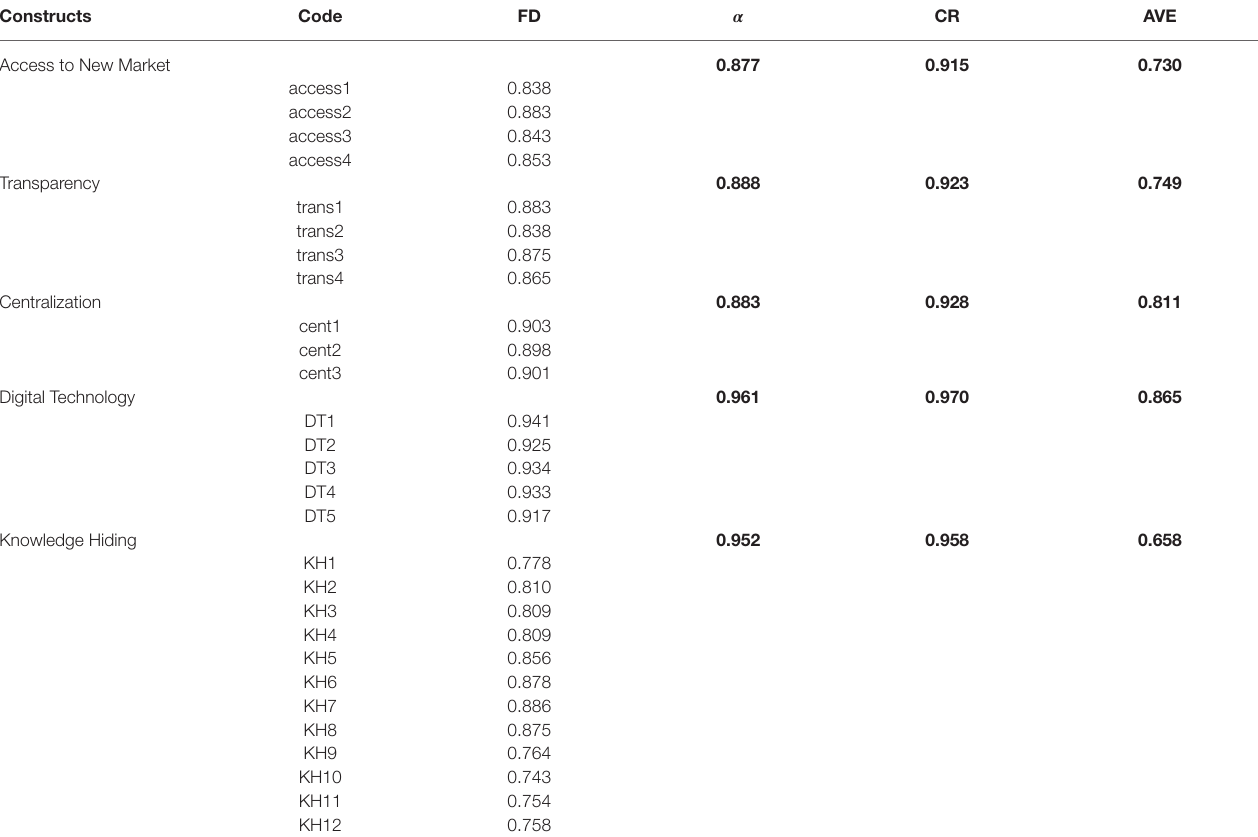
TABLE 2 | Model measurements.